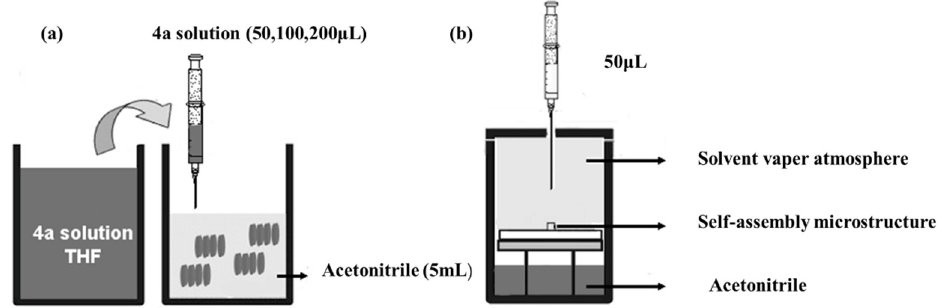
Figure 3. Fabrication steps for the preparation of 4a – 4d microstructures. ( a ) The first step: the compounds through the solvent-exchange method in the solution phase, which transfers the molecule from a good solvent (THF) into a poor solvent (acetonitrile, 5 mL); ( b ) the second step: the solution dropping to a SiO 2 substrate. The solvent is allowed to evaporate slowly or quickly in a closed jar, giving rise to different microstructures.